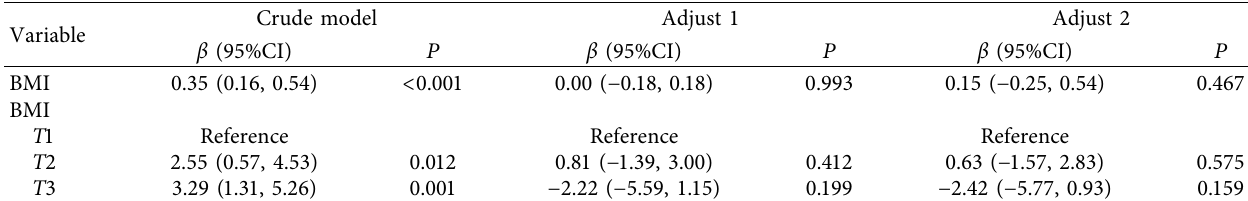
Table 3: Relationship between BMI and cognitive function in diferent models.